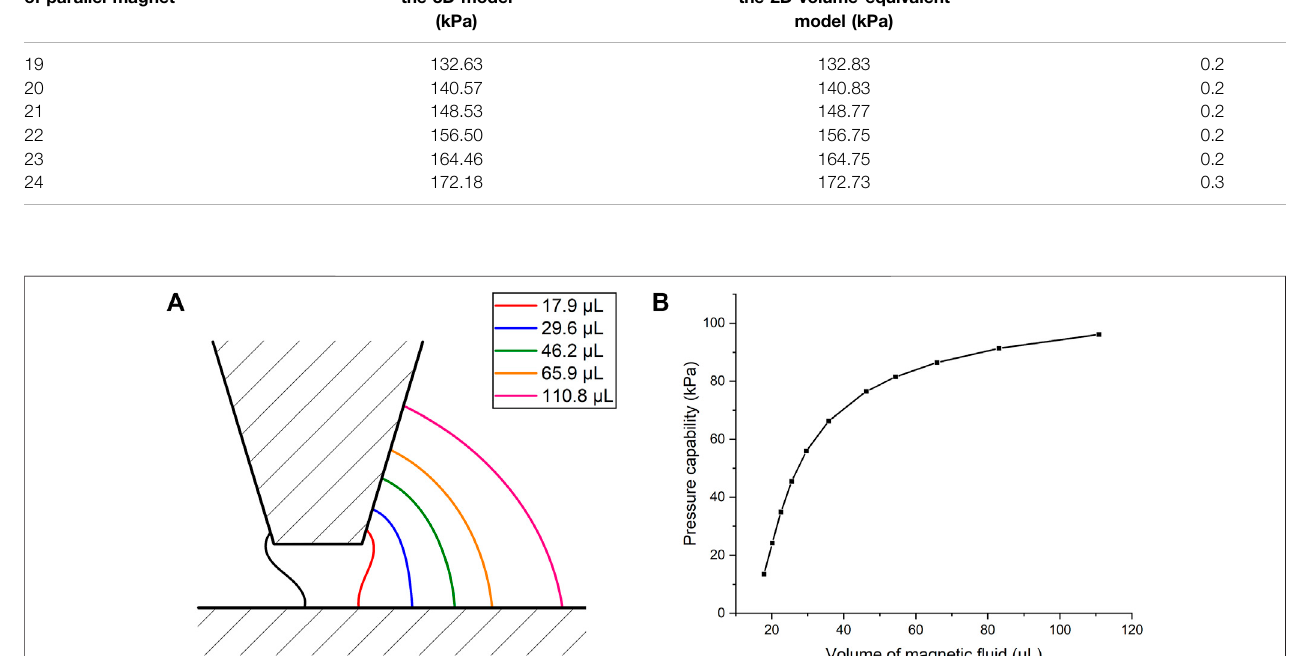
TABLE 2 | Pressure capability of 3D and 2D volume-equivalent models with parallel magnets. Number of parallel